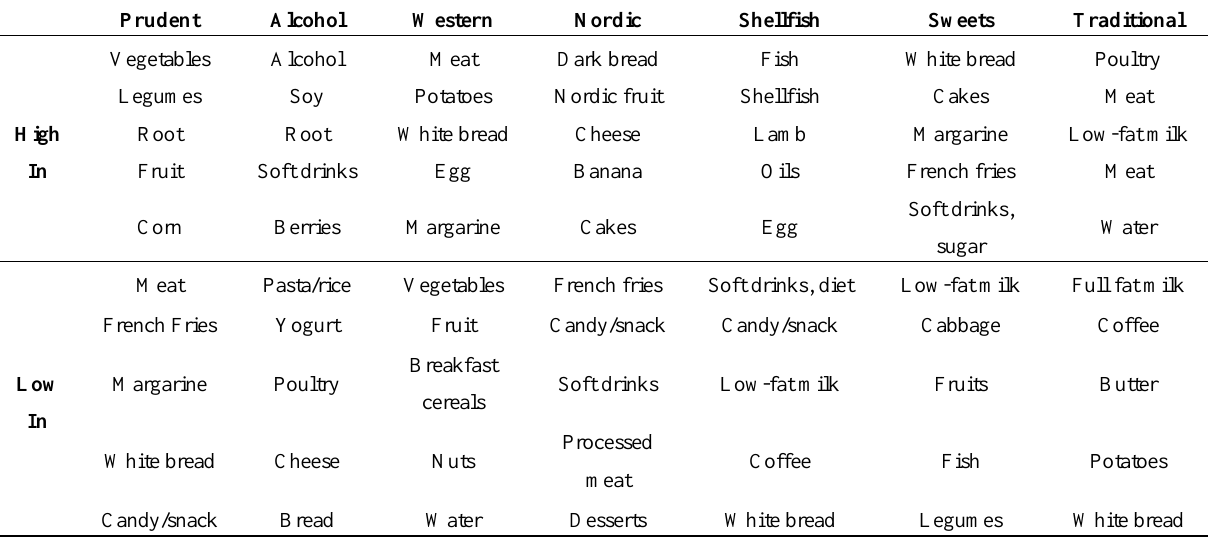
Table 1. Short characterization of the seven dietary patterns in the Danish National Birth